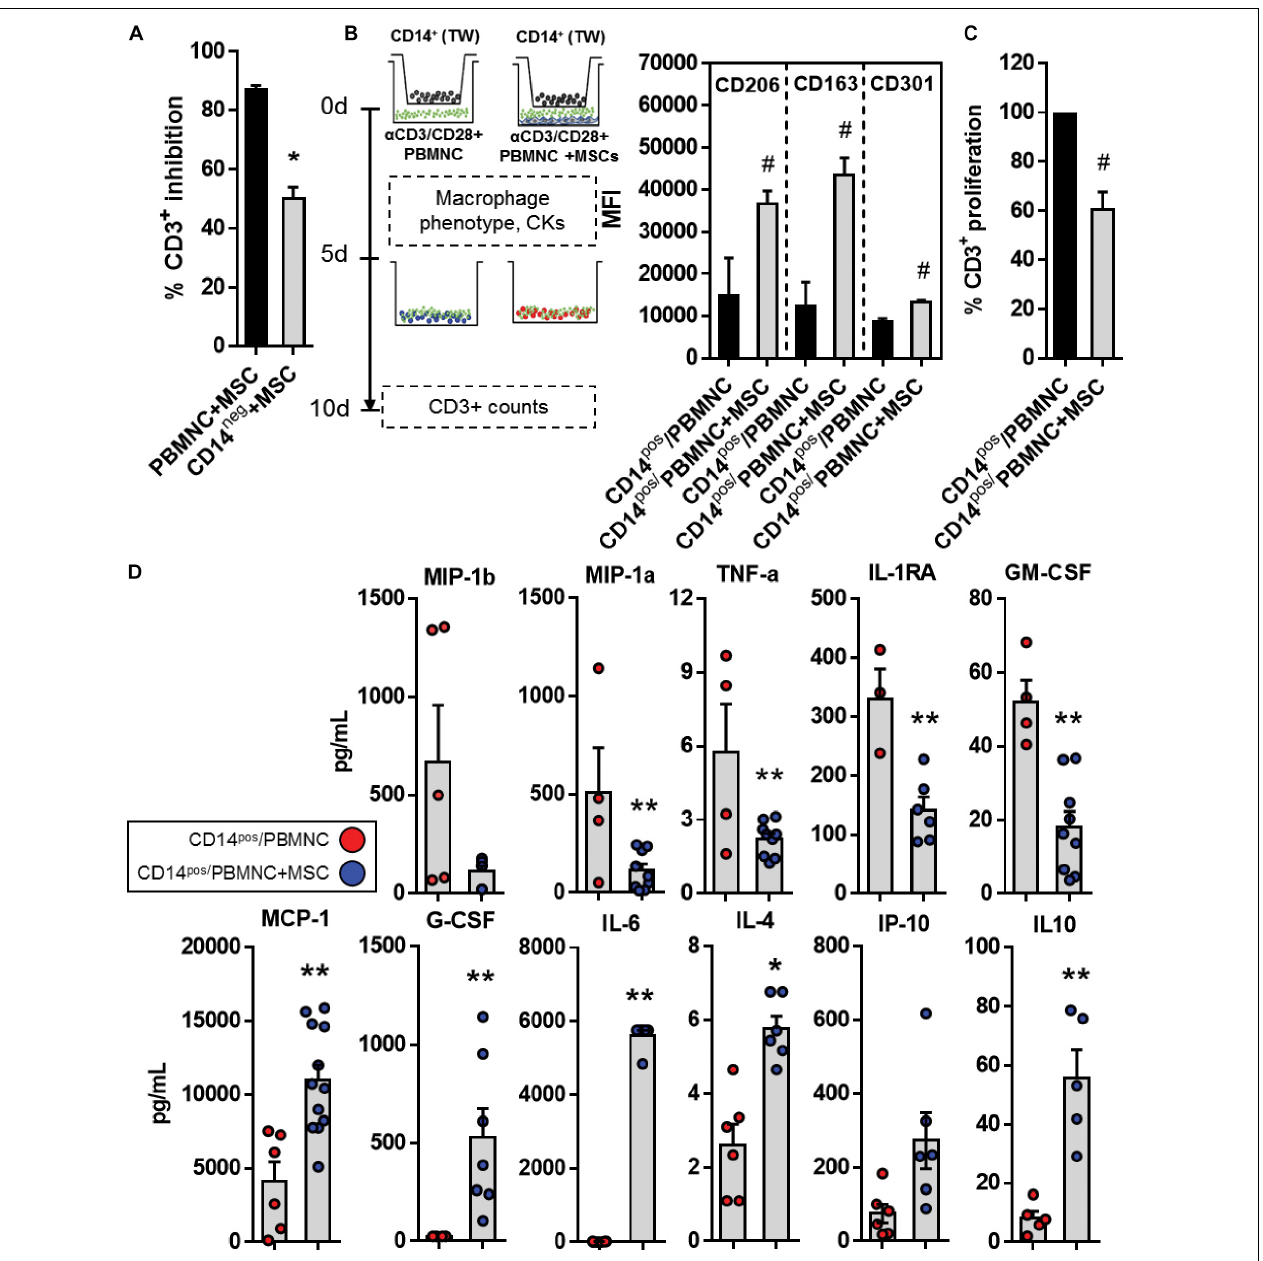
FIGURE 5 | UC-MSC trigger reprogramming of M1 toward M2-Macrophage. (A) Percentage of CD3 + T cell suppression in α CD3/CD28-activated PBMNC/UC-MSC or monocyte-depleted (CD14 neg )-PBMNC/UC-MSC cocultures (* p < 0.01, n = 3). (B) CD14 pos monocytes were preconditioned with UC-MSC under experimental inflammation. CD14 pos cells were purified, seeded in the upper chamber of 1 µ m-pore transwell inserts and exposed to activated autologous PBMNC (CD14 pos /PBMNC), or activated PBMNC/UC-MSC cocultures (CD14 pos /PBMNC+MSC) for 5 days. Preconditioned monocytes (CD14 pos /PBMNC or CD14 pos /PBMNC+MSC) were further transferred to activated autologous CD3 + cells and T cell suppression was determined 5 days post culture. Expression of M2-like markers CD206, CD163, and CD301 in preconditioned CD14 pos monocytes at day 5 was determined (# vs. CD14 pos /PBMNC, p = p < 0.05, n = 3–4). (C) Percentage of CD3 + T cell proliferation after culture with CD14 pos /PBMNC or CD14 pos /PBMNC+MSC monocytes in a ratio 10:1 (CD3 + :CD14 pos ) (# vs. CD14 pos /PBMNC, p < 0.05, n = 3). (D) Supernatants from CD14 pos /PBMNC or CD14 pos /PBMNC+MSC were collected and analyzed for cytokine, chemokines and growth factor production following preconditioning experiments (** vs. CD14 pos /PBMNC, p = 0 < 0.05, n = 4–8).